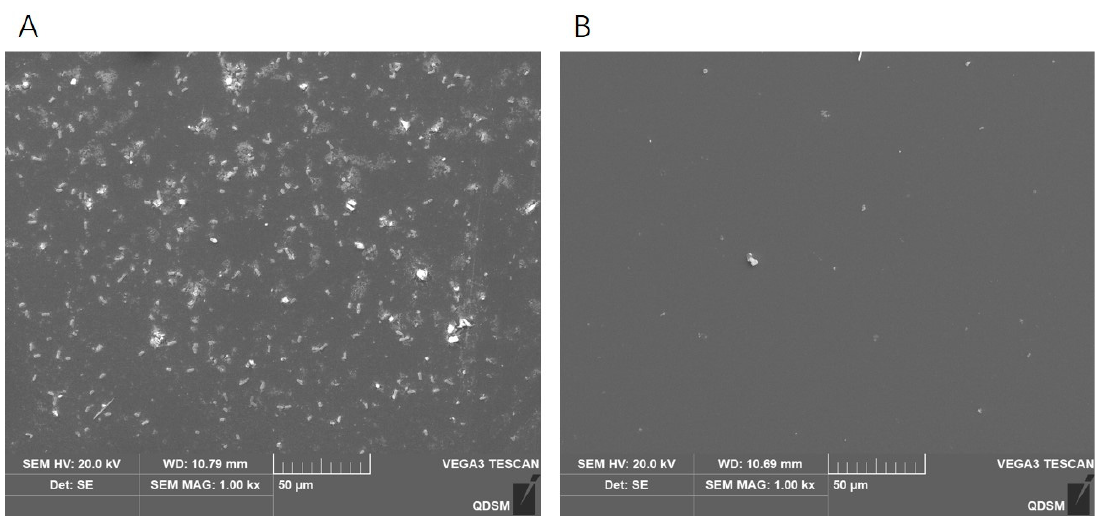
Figure 9. Eradication of C. perfringens D22 biofilms by phage DCp1. ( A ) SEM image of untreated C. perfringens D22 biofilm. ( B ) SEM image of phage DCp1-treated C. perfringens D22 biofilm.